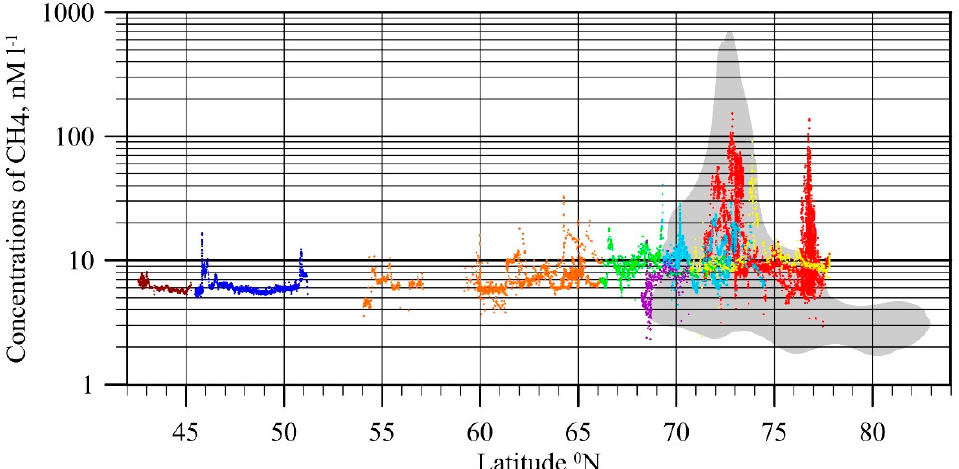
Figure 5. Distribution of dissolved CH 4 in the surface water of the ESAS and other northern / far-eastern seas collected in 2004–2012 using two di ff erent types of sampling. Levels of dissolved CH 4 permanently measured in the surface water along the ship’s track in particular seas in 2011 and 2012 are shown in di ff erent colors; brown—Sea of Japan; dark blue—the Sea of Okhotsk; orange—the Bering Sea; green—the Chukchi Sea; purple—the Barents Sea; light blue—the East Siberian Sea; yellow—The Kara Sea, red—the Laptev Sea; the gray shadow presents the combined data set obtained in the surface water of the Laptev and the East Siberian seas in September–October 2004–2012 by sampling using a Niskin bottle (modified after